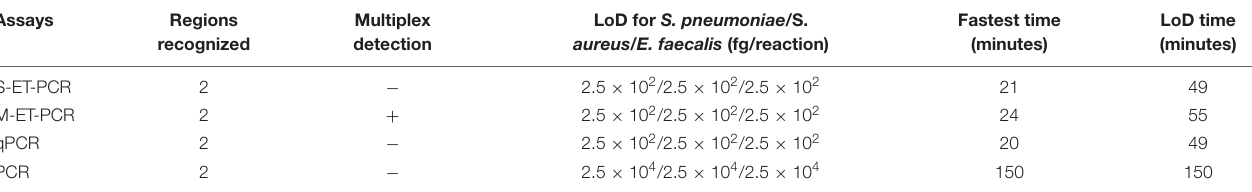
TABLE 3 | The analytical sensitivity for ET-PCR targeting ply , nuc, and Ef0027 genes compared with that of conventional qPCR (SYBR Green) and PCR approaches. Assays Regions